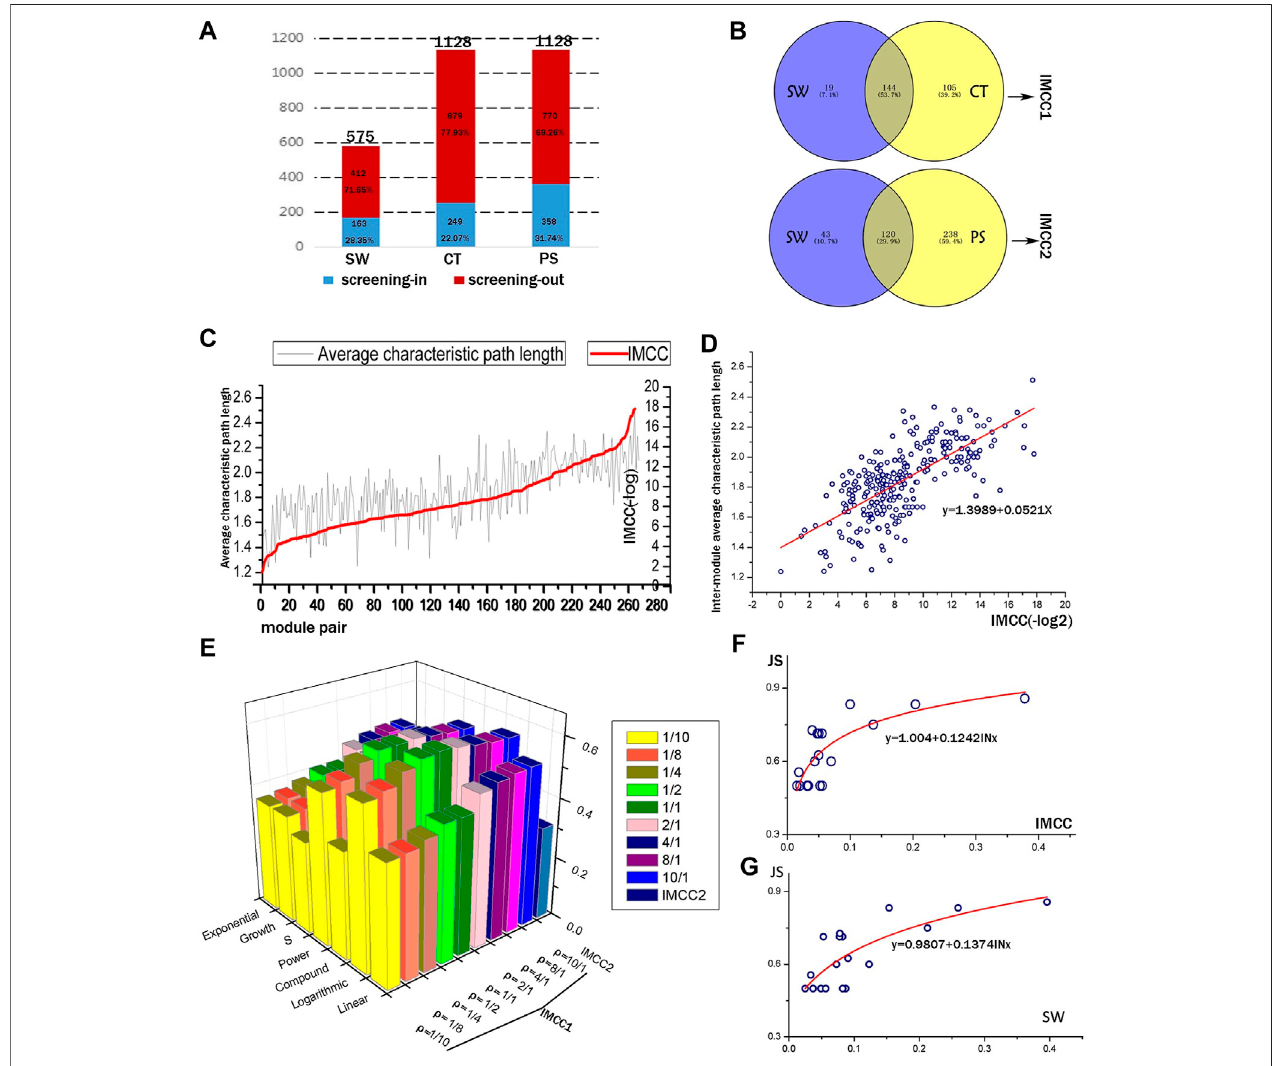
FIGURE 2 | Quantitative evaluation of the IMCC method. (A) The screening outcomes of the three inter-module connectivity parameters (SW, CT, and PS). The height of the column represents the total amount of SW, CT, and PS, respectively. Red and blue parts of the columns represent the screened out and the remaining parameters, respectively. (B) The overlapping condition oftwo parameters tobe integrated as IMCC 1 and IMCC 2 . (C) The IMCC value against the inter-module average characteristicpathlength(IMASP)ofmodulepairs. (D) Scatterplotandlinear fi ttingoflog2transformationofIMCCvs.IMASP.Theformulaisy (cid:1) 0.0521x+1.3989, with R 2 (cid:1) 0.493. (E) The R 2 of multiple fi tting models for IMCC and JS. (F,G) are the fi tting curves of logarithmic model of JS and IMCC, JS, and